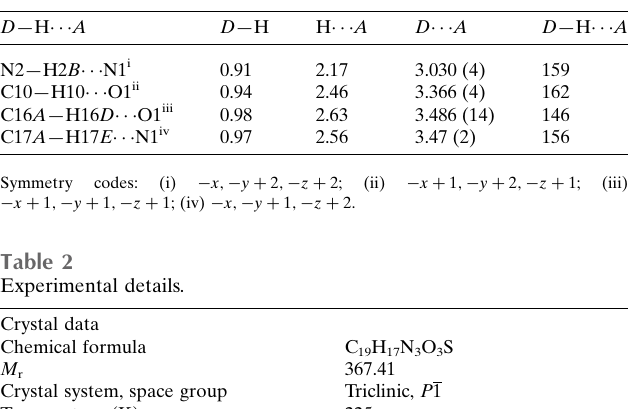
Table 1 Hydrogen-bond geometry (A˚ , (cid:4) ).